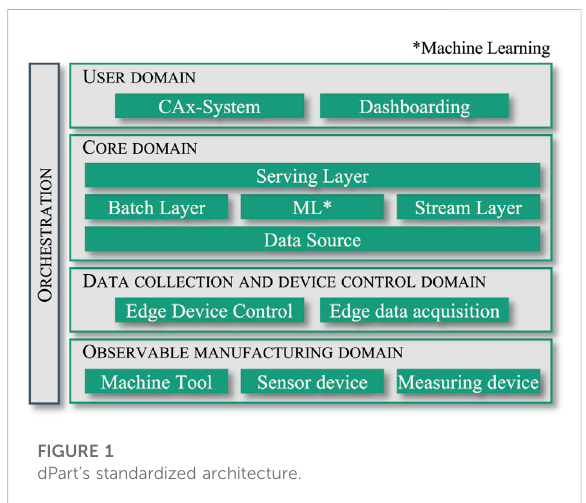
FIGURE 1 dPart ’ s standardized